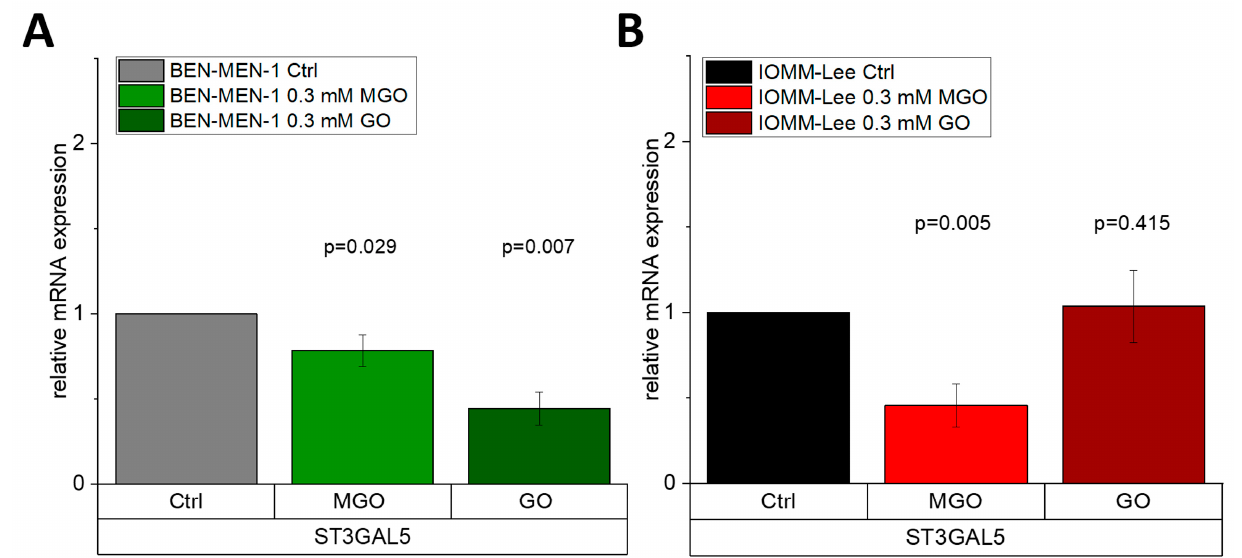
Figure 8. Relative mRNA expression of ST3GAL5 in BEN-MEN-1 ( A ) and IOMM-Lee ( B ). A shows the relative expression of ST3GAL5 in untreated (grey), 0.3 mM MGO (green)- and 0.3 mM GO (dark green)-treated BEN-MEN-1. B shows the relative expression of ST3GAL5 in untreated (black), 0.3 mM MGO (red)- and 0.3 mM GO (dark red)-treated IOMM-Lee. Statistical analysis was performed using t -test and error bars represent SD (n = 4; ST3GAL5 GO ( A ) p = 0.007; ( B ) p = 0.415).